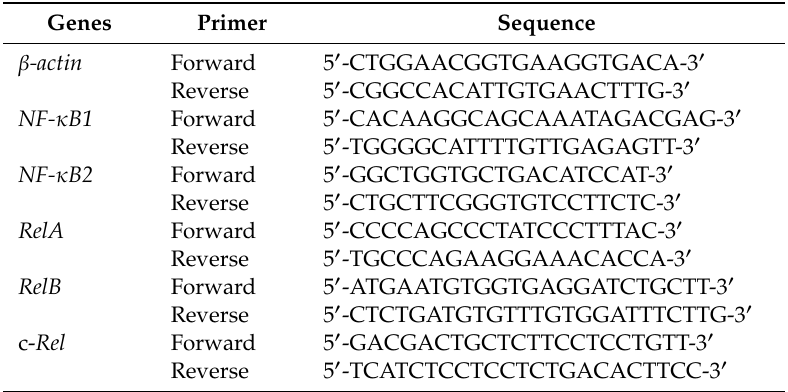
Table 2. Primers used in real-time quantitative